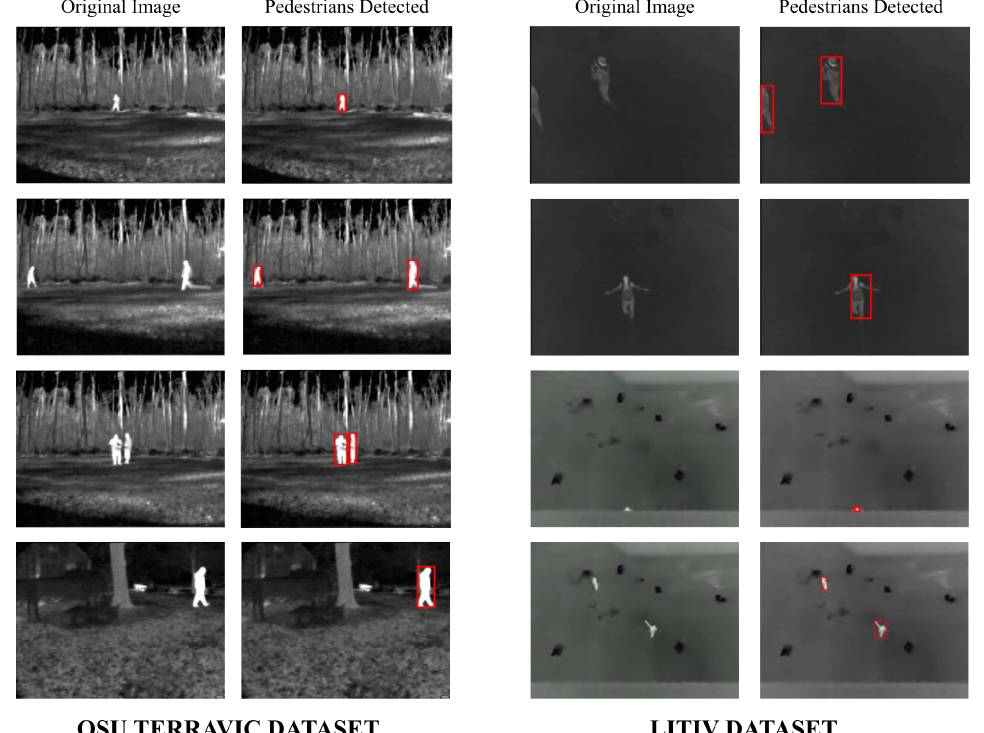
Figure 8. Detected pedestrians on images from the LITIV and Terravic dataset after